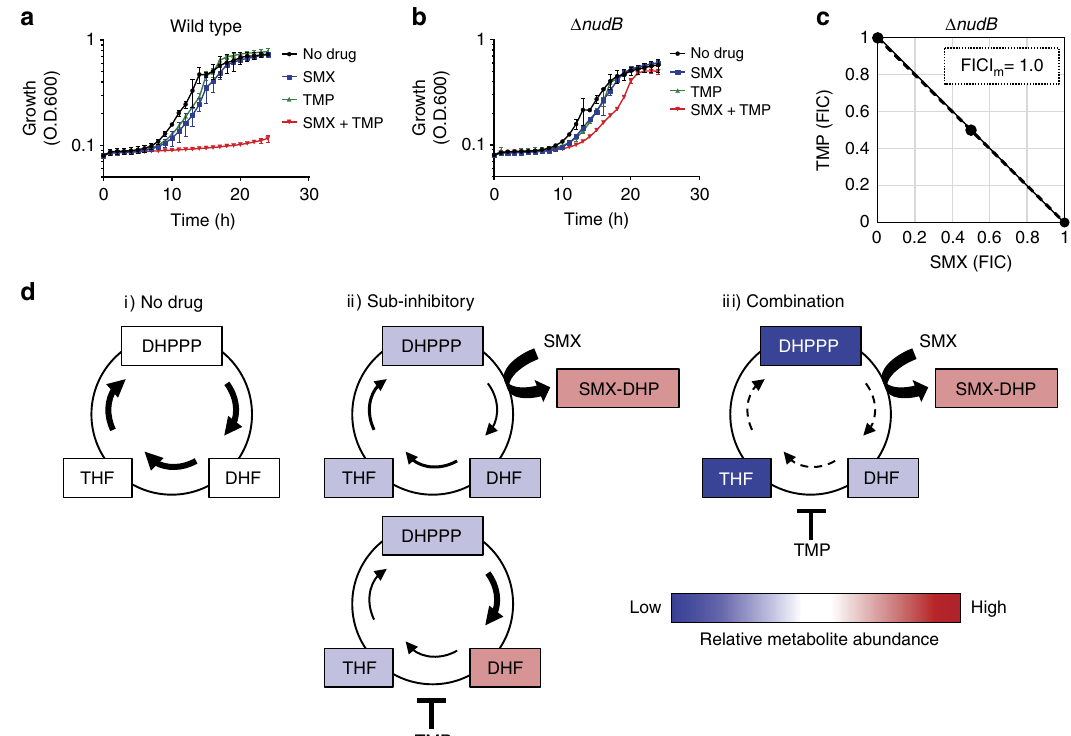
Fig. 4 A metabolic feedback loop ampli fi es SMX-TMP activity. a , b SMX-TMP synergy was assessed by growth kinetics in the presence of a sub-inhibitory concentration of each drug and in combination. The results represent the mean and SD of three biological replicates. a Wild type ( E . coli BW25113 strain) was grown in the presence of SMX (0.06 µ g ml − 1 ), TMP (0.125 µ g ml − 1 ), or a combination of SMX (0.06 µ g ml − 1 ) and TMP (0.125 µ g ml − 1 ). b Δ nudB ( E . coli BW25113 Δ nudB ) was grown in the presence of SMX (0.003 µ g ml − 1 ), TMP (0.0125 µ g ml − 1 ), or a combination of SMX (0.003 µ g ml − 1 ) and TMP